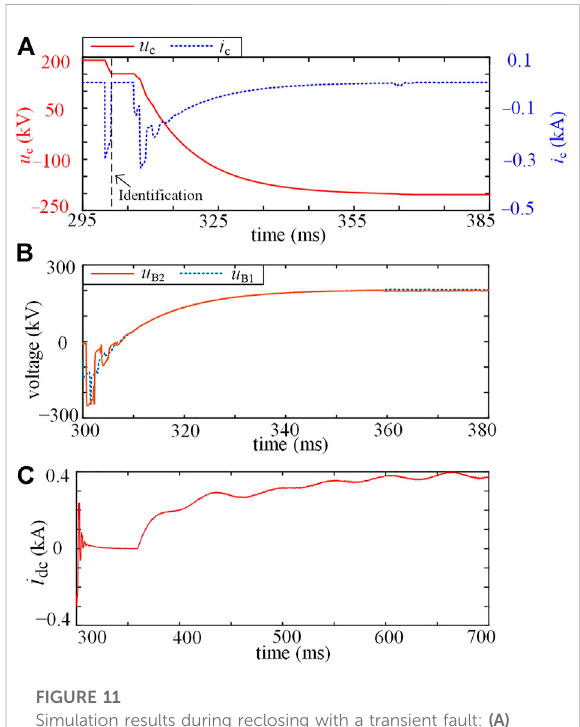
FIGURE 11 Simulation results during reclosing with a transient fault: (A) the value of uc and ic; (B) line voltages uB1 and uB2; (C) line current